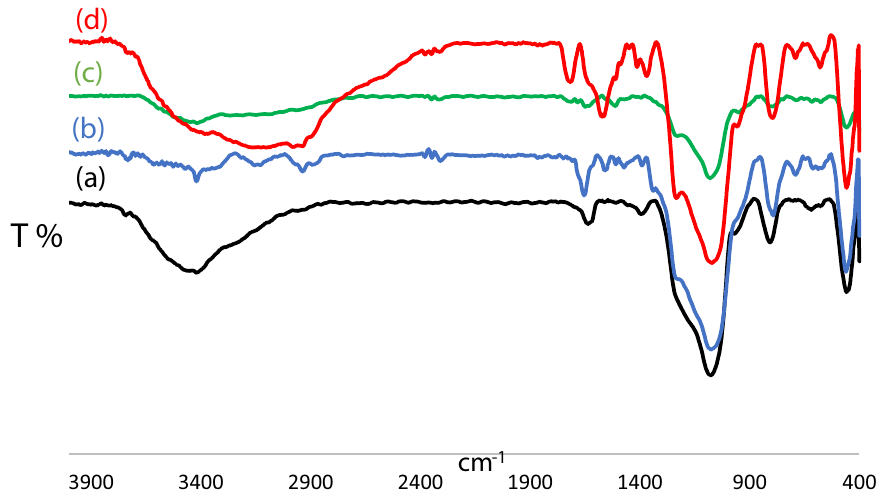
Figure 1. FTIR spectra of the MCM-41 ( a ), MCM-41-APS ( b ), MCM-41-APS-PMDA ( c ) and MCM-41-APS- PMDA-NHSO